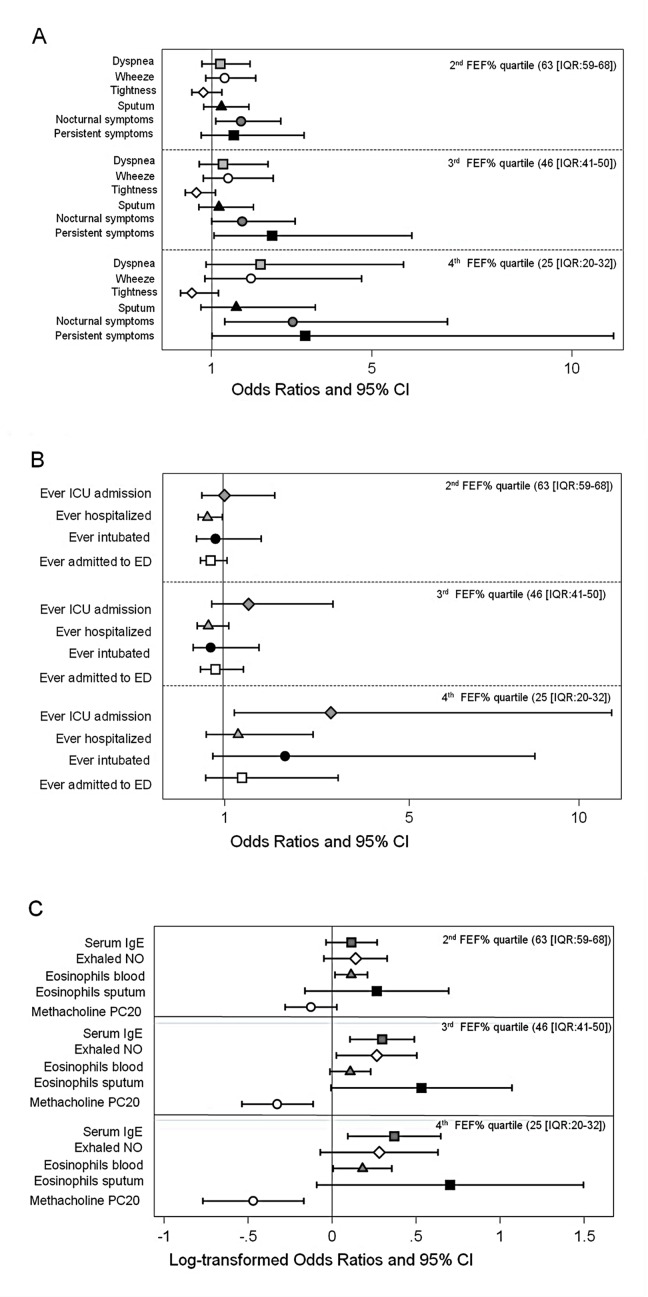
Adjusted odds ratios and beta coefficients of respiratory symptom frequency (a), healthcare utilization (b), biomarkers and bronchial hyperresponsiveness (c).Footnote: Multivariable logistic and regression models adjusted for: for age, sex, body mass index, duration of asthma, history of smoking, FEV1 and FEV1/FVC. Error bars represent 95% confidence intervals.